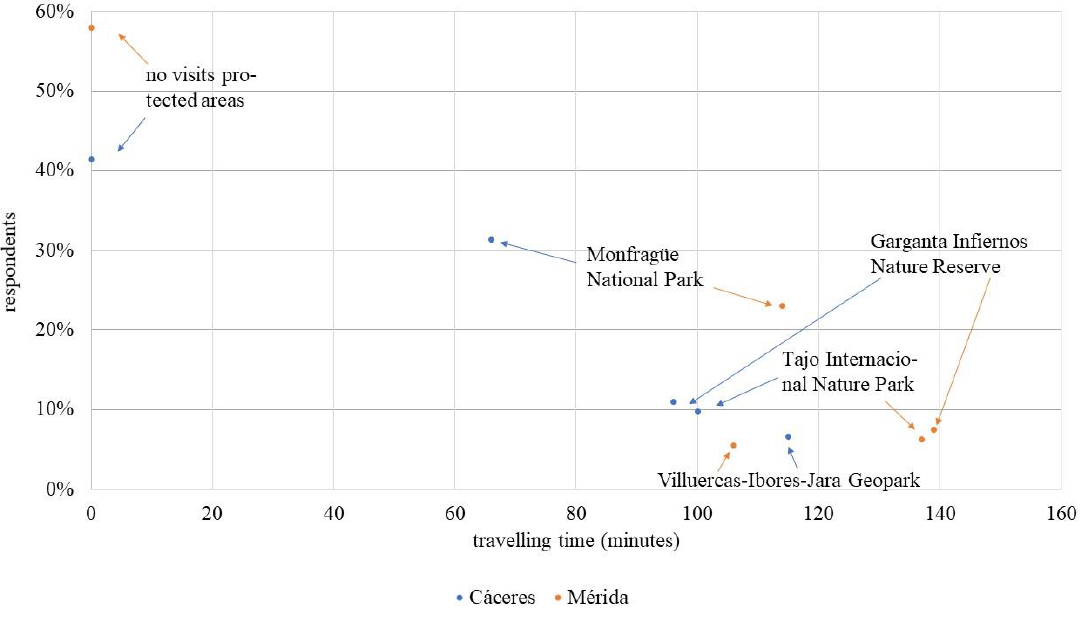
Figure 3. Visitors and travel times.